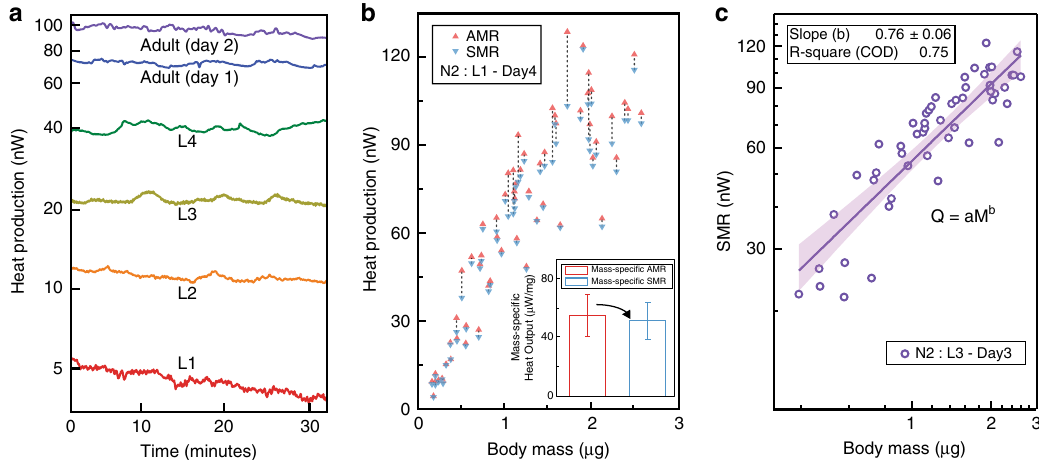
Fig. 4 Size-dependent metabolic heat output measurements on N2 wild-type. a Real-time metabolic heat output pro fi les of referential C. elegans from L1 stage to Adult (Day 2) stage. b Metabolic heat output measurements of N2 wild-type worms ( n = 61 independent trials) at different stages from L1 to Adult (Day 4). The red and blue triangles represent the AMR and SMR of individual worms, respectively, and are connected by a black dashed line to identify measurements from individual worms. The inset shows the mass-speci fi c AMR (red) and SMR (blue) averaged over 61 N2 wild-type worms while the error bars represent the standard deviation (±SD) about the mean. c SMR vs. body size on a log-log plot to extract an allotropic scaling constant of 0.76 from ( n = 52 independent trials) wild-type N2 samples from L3 to Adult (Day 3). The purple solid line represents the best- fi t with R-squared error of 0.75. The purple shaded region indicates the 95% con fi dence